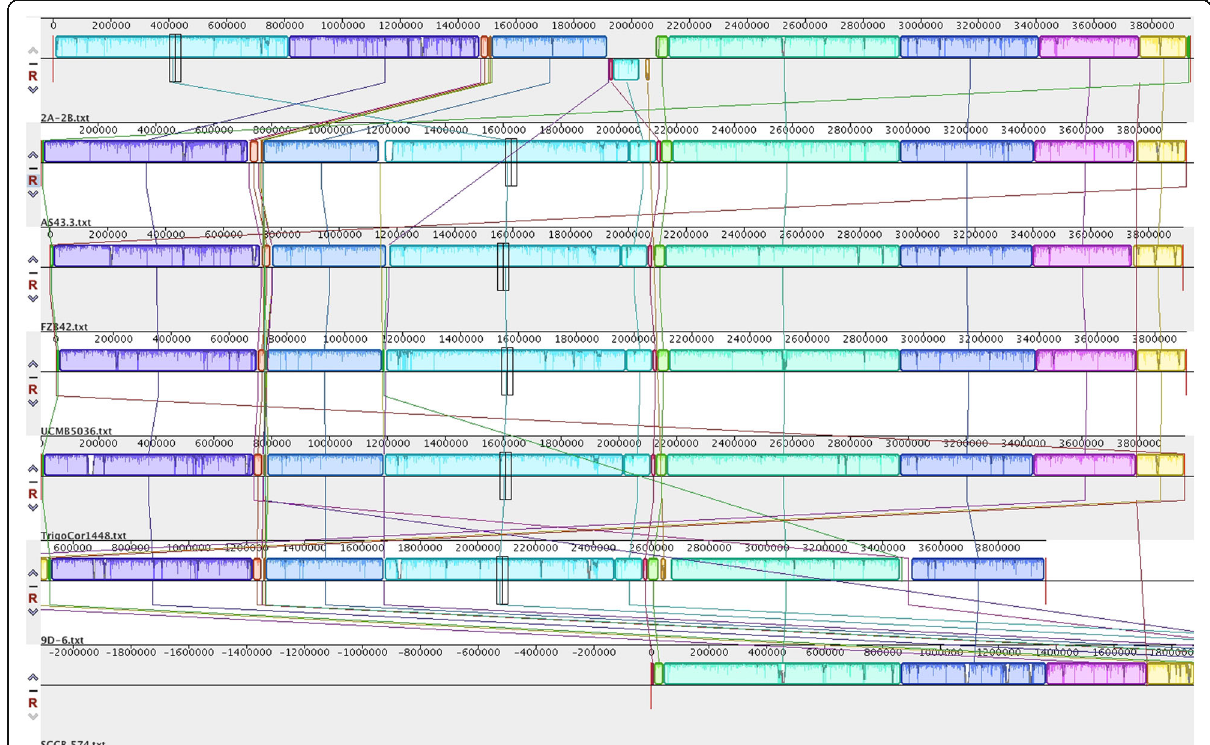
Fig. 7 Multiple genome comparisons of 2A-2B and other 6 genomes, as a sample of the 89 B. velezensis genomes so far accessed in the NCBI GeneBank. In the 2A-2B B. velezensis strain genome 19 locally collinear blocks (LCBs) are found, this genome with two mayor rearrangements that imply the mayor LCB and a segment including three other LCBs in inverted orientation. The genome comparisons were performed with MAUVE software